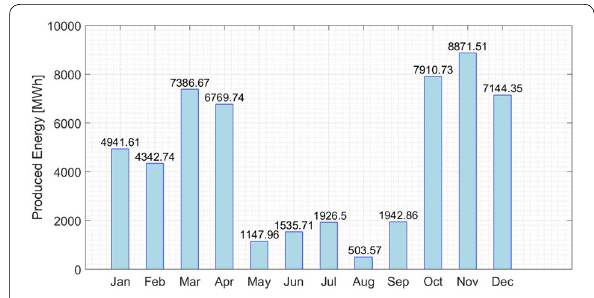
Table 9 São Jorge system design data with polycrystalline